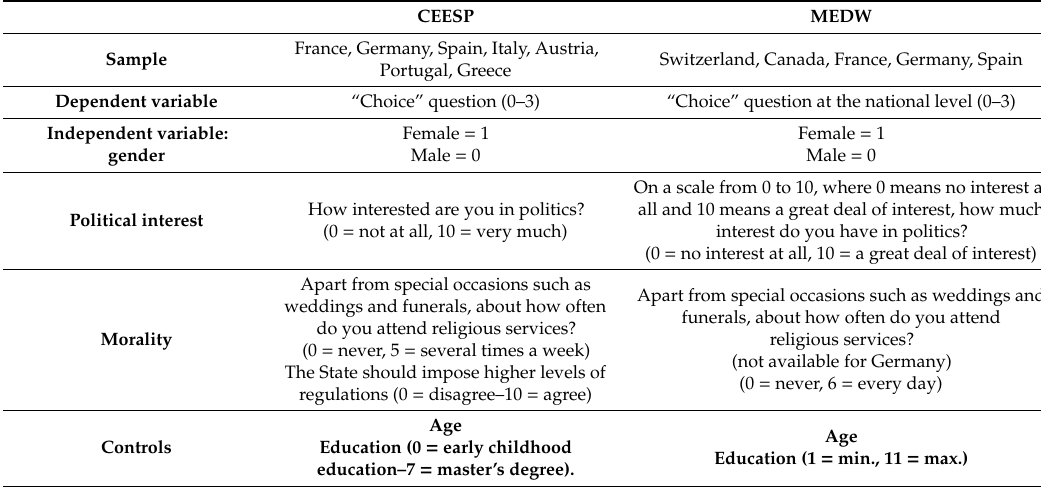
Table 2. Operationalization of the main variables for each dataset. CEESP: Centre d’ É tudes Europ é enes of SciencePo; MEDW: Making Electoral Democracy